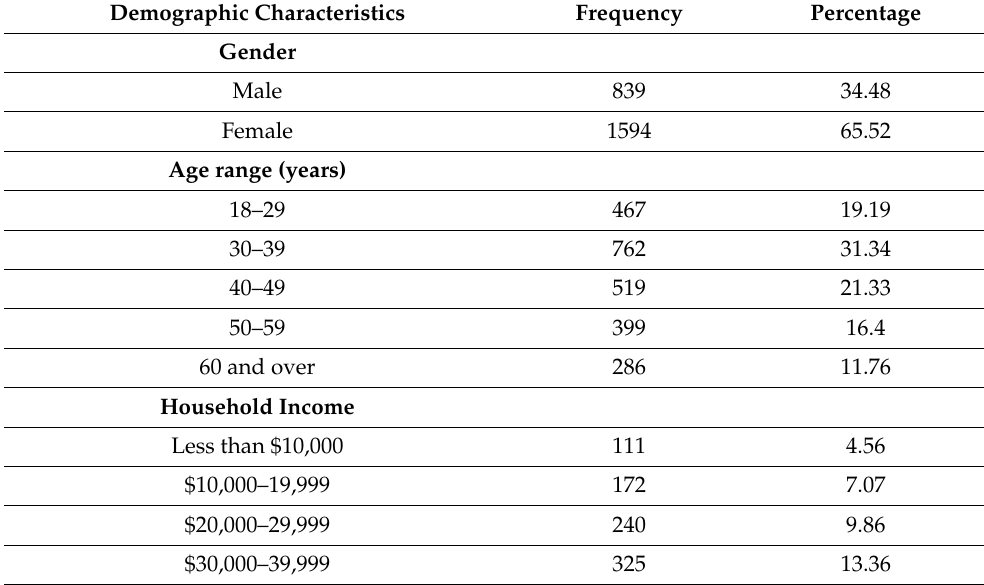
Table 4. Demographic Characteristics of Participants ( N =